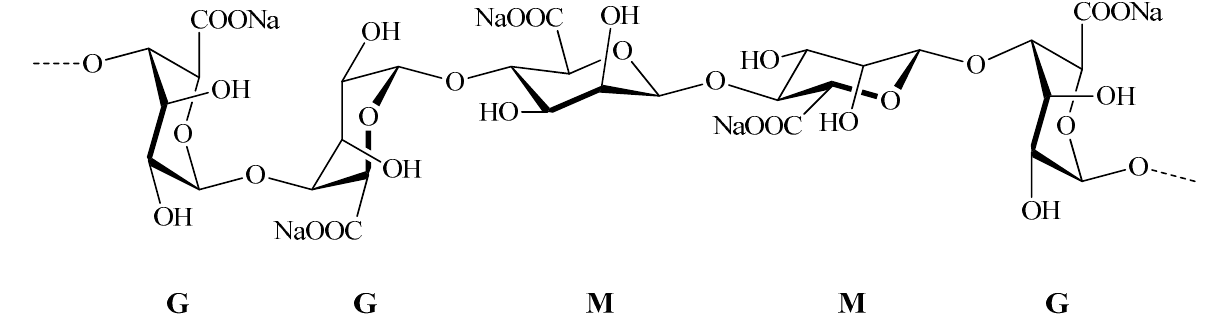
Figure 1. Molecular structure of sodium alginate.